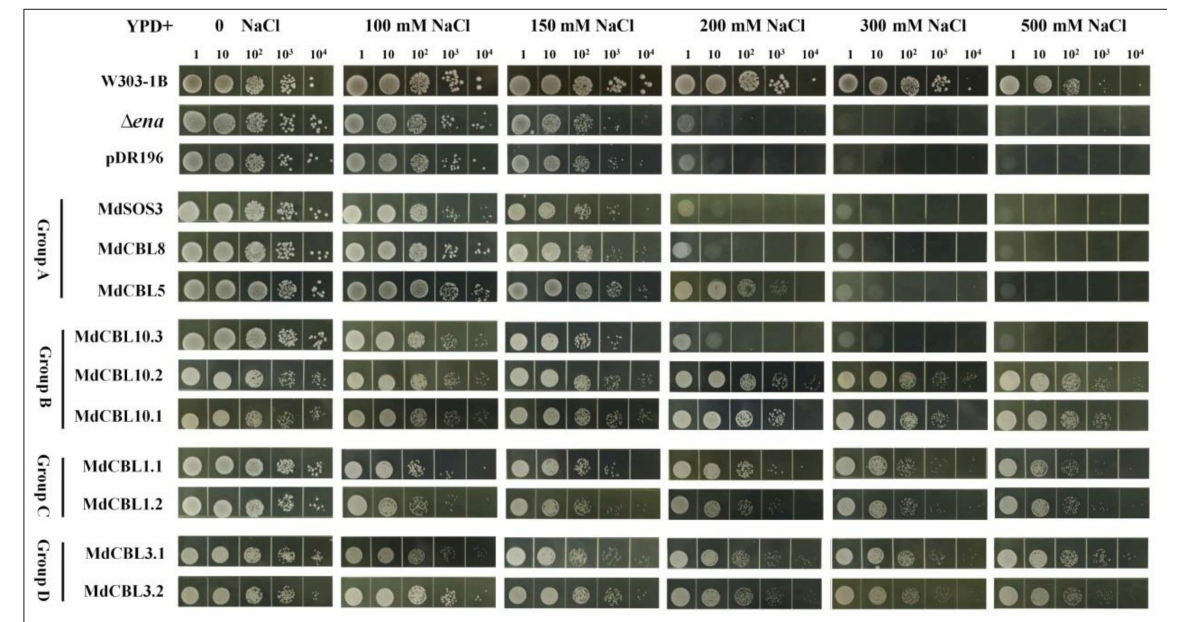
Figure 4. Functional identification of MdCBLs in the Na + -sensitive yeast mutant. Aliquots (10 µ L) of serial dilutions (10 0 , 10 1 , 10 2 , 10 3 , and 10 4 ) were dotted onto the YPD medium in the presence of 0, 100, 150, 200, 300, and 500 mM NaCl and grown for 3 days. W303-1B was the positive control. ∆ ena1 − 4 and ∆ ena1 − 4 transformed with the pDR196 empty vector were used as negative